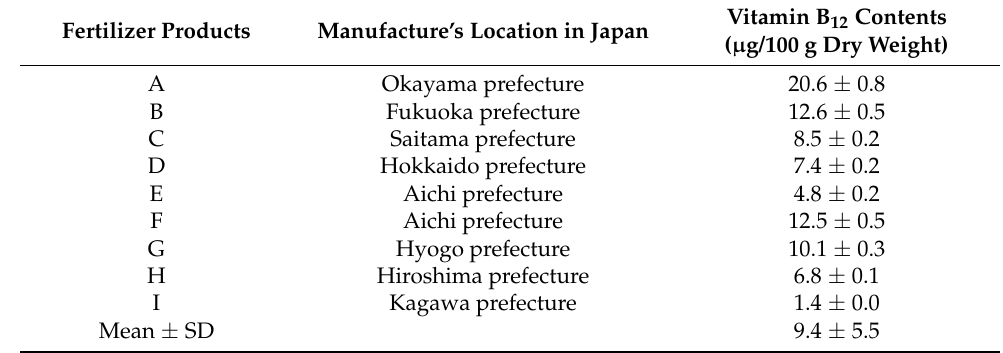
Table 1. Vitamin B 12 contents in nine types of commercially available fermented poultry manure organic fertilizer products. B 12 was extracted from various fermented poultry manure products by the KCN-boiling method and determined by the microbiological method as described in the